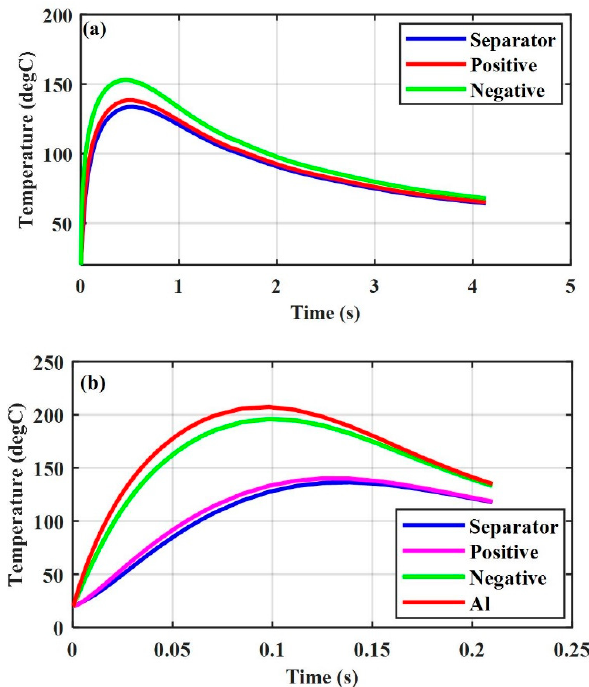
r Figure 4. Thermal response of various ISC areas, SOC = 0.4, aluminum-negative ( a ) r = 0.5 mm, and in in r in